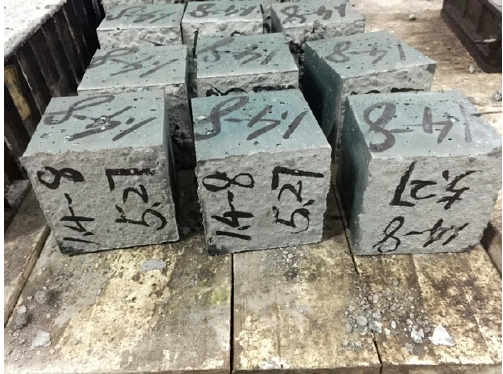
Figure 3. Compressive strength test specimens.